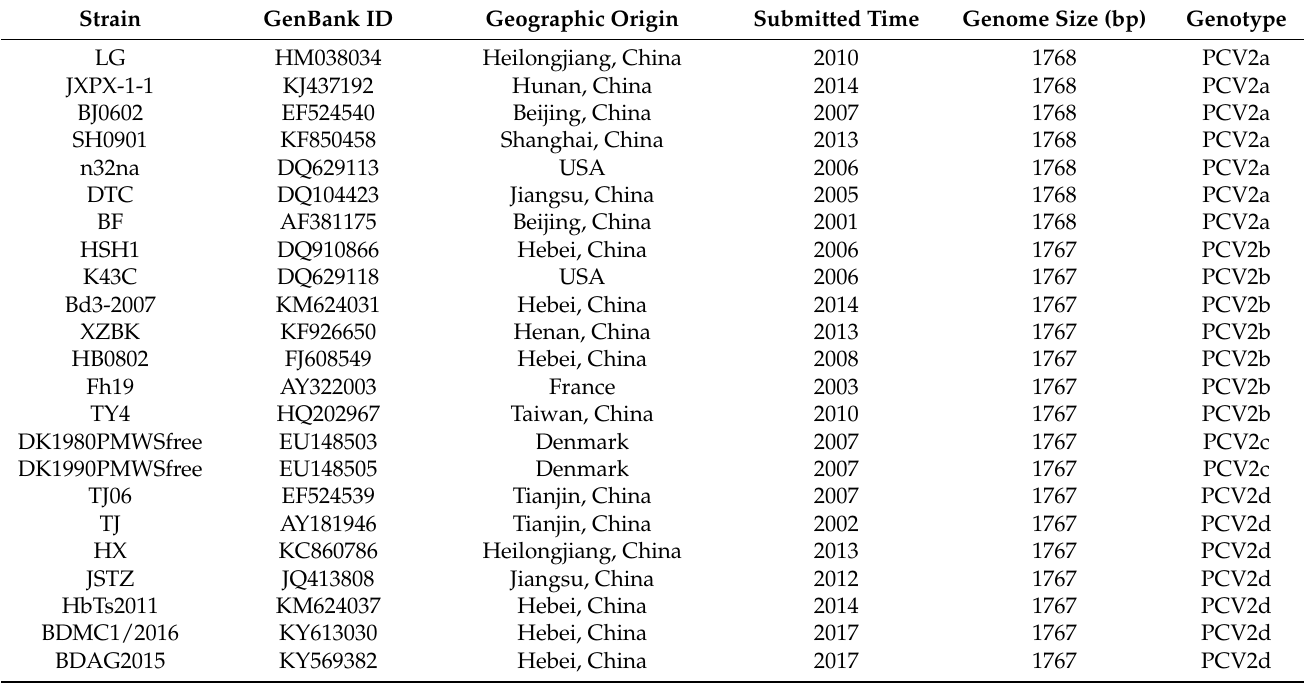
Table 2. The information of PCV2 reference strains used in this